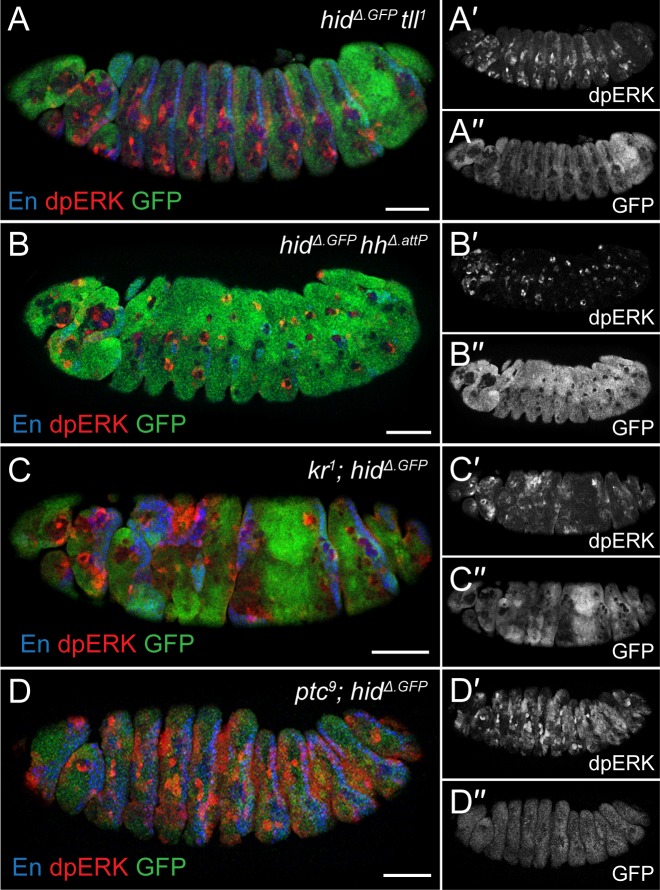
hid and dpERK are anticorrelated in various patterning mutants.(A–D) GFP and dpERK immunoreactivity in hidΔ.GFP
tll1 (A), hidΔ.GFP
hhΔ.attP (B), kr1; hidΔ.GFP (C), and ptc9; hidΔ.GFP (D) stage 13 double mutants. In each instance, dpERK intensity and hidΔ.GFP expression are anticorrelated. Scale bars 50 μm. dpERK, phosphorylated extracellular signal–regulated kinase; GFP, green fluorescent protein; hh, hedgehog; hid, head involution defective; kr, krüppel; ptc, patched; tll, tailless.